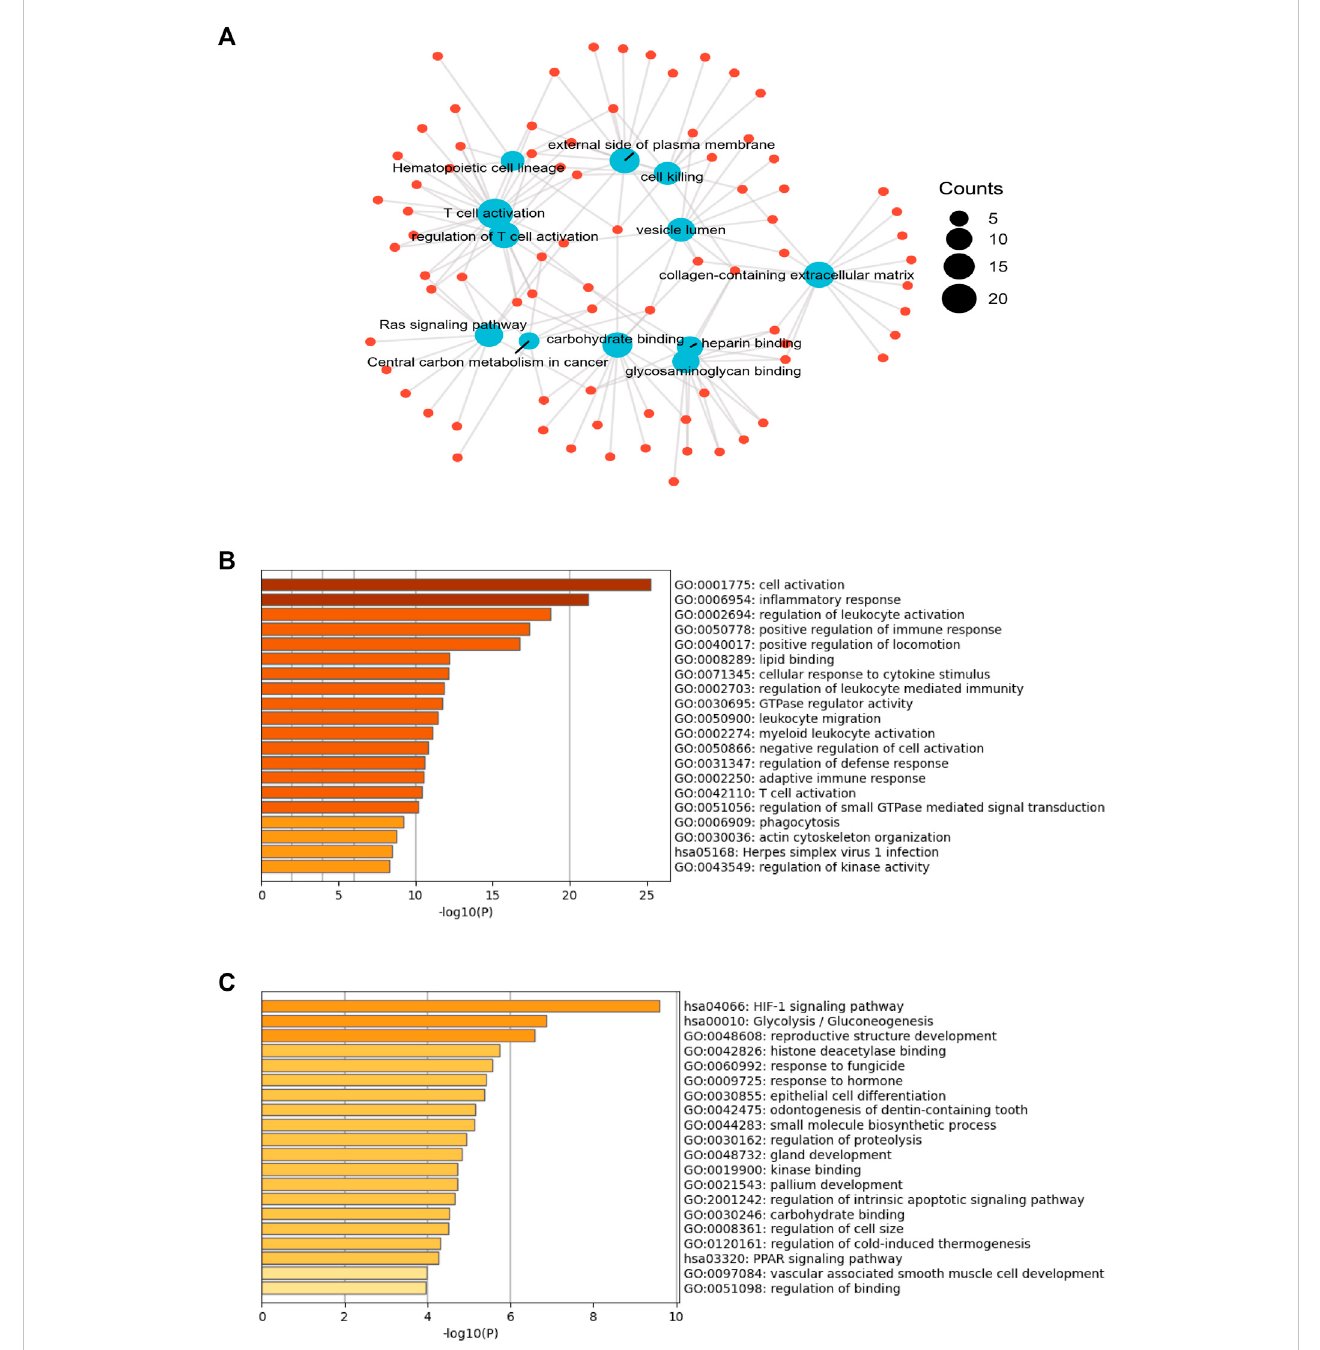
FIGURE 1 The gene expression pro fi les in chemotherapy-sensitive and resistant hypopharyngeal cancer patient tissues. (A) Gene oncology (GO)-biological processes(BP),GO-molecularfunctions(MF)andKyotoencyclopediaofgenesandgenomes(KEGG)analysisof1,310genesshowedsigni fi cantdifferencesin the expression levels of tissues from the non-sensitive group compared to the sensitive group ( p < .05) based on mRNA-targeted genes. (B) The GO enrichmentanalysisandKEGGpathway analysis forevaluating188up-regulatedgenesintheresistant group. (C) TheGO enrichmentanalysisand KEGG pathway analysis for evaluating 60 up-regulated genes in the sensitive